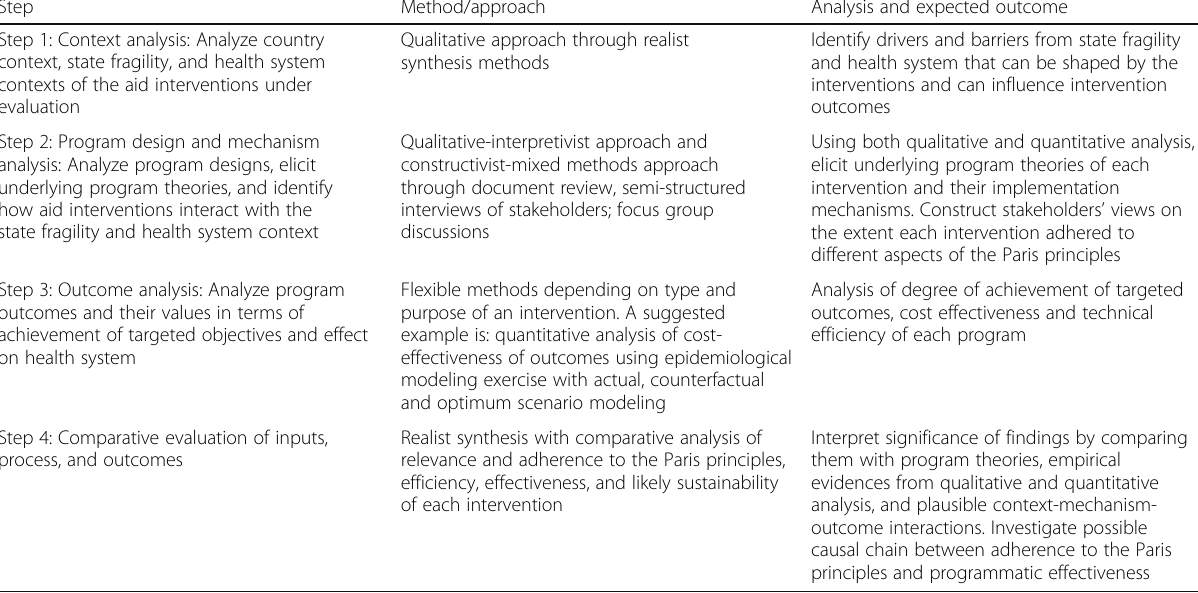
Table 1 Summary of evaluation design and methods Step Method/approach Analysis and expected outcome